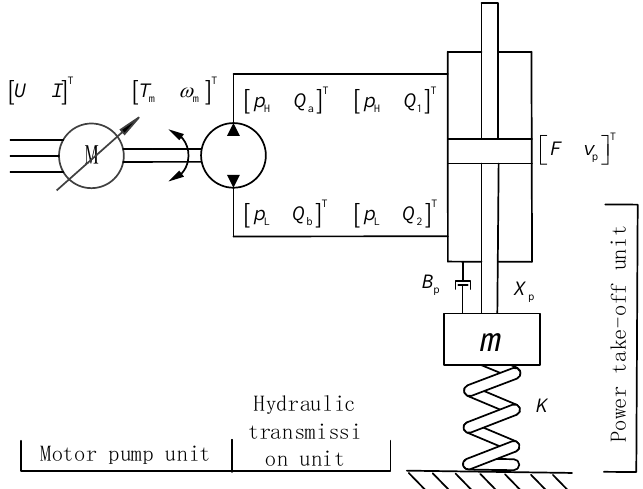
Figure 2. System composition diagram of electro-hydraulic coupling unit.